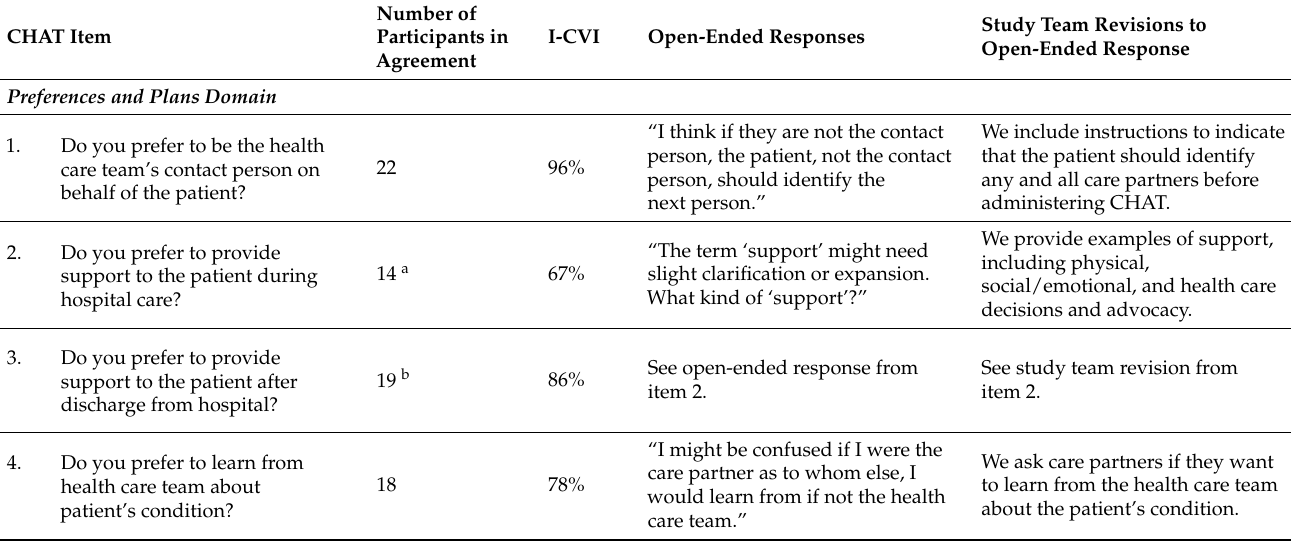
Table 2. I-CVI scores, open-ended responses from participants, and study team revisions for